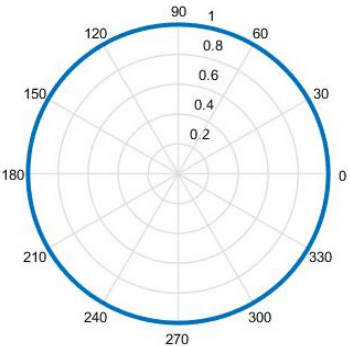
Figure 2. Directivity of the piezoelectric tube. From Figures 1 and 2, we can see that neither the single cilium MEMS vector hy- drophone nor the piezoelectric tube transducer can achieve underwater positioning sepa- rately. In this paper, a composite hydrophone that was designed, used the cilium MEMS vector hydrophone as the vector channel and the piezoelectric circular tube as the scalar channel. The composite hydrophone can not only receive velocity information, but also synchronously receive sound pressure information in the sound field. As shown in Figure 3, when sound pressure and vibration velocity are combined in ( p + V i ) and ( p + V ) V ( i = x , y ) modes, they have different unidirectional directivity. The schematic i i diagram of the composite hydrophone is shown in Figure 4. There are the following three parts: vector channel, scalar channel, and preamplifier casing, where the signal processing PCB lies. The vector channel is a cilium bionic MEMS microstructure, wrapped in a cap filled with silicone